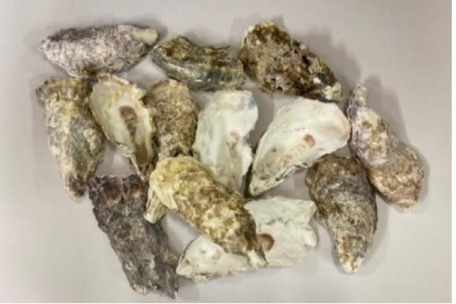
Figure 1. Oyster shells collected from the coasts of Nosan-ri, Gwangdo-myeon, and Tongyeong-si (South